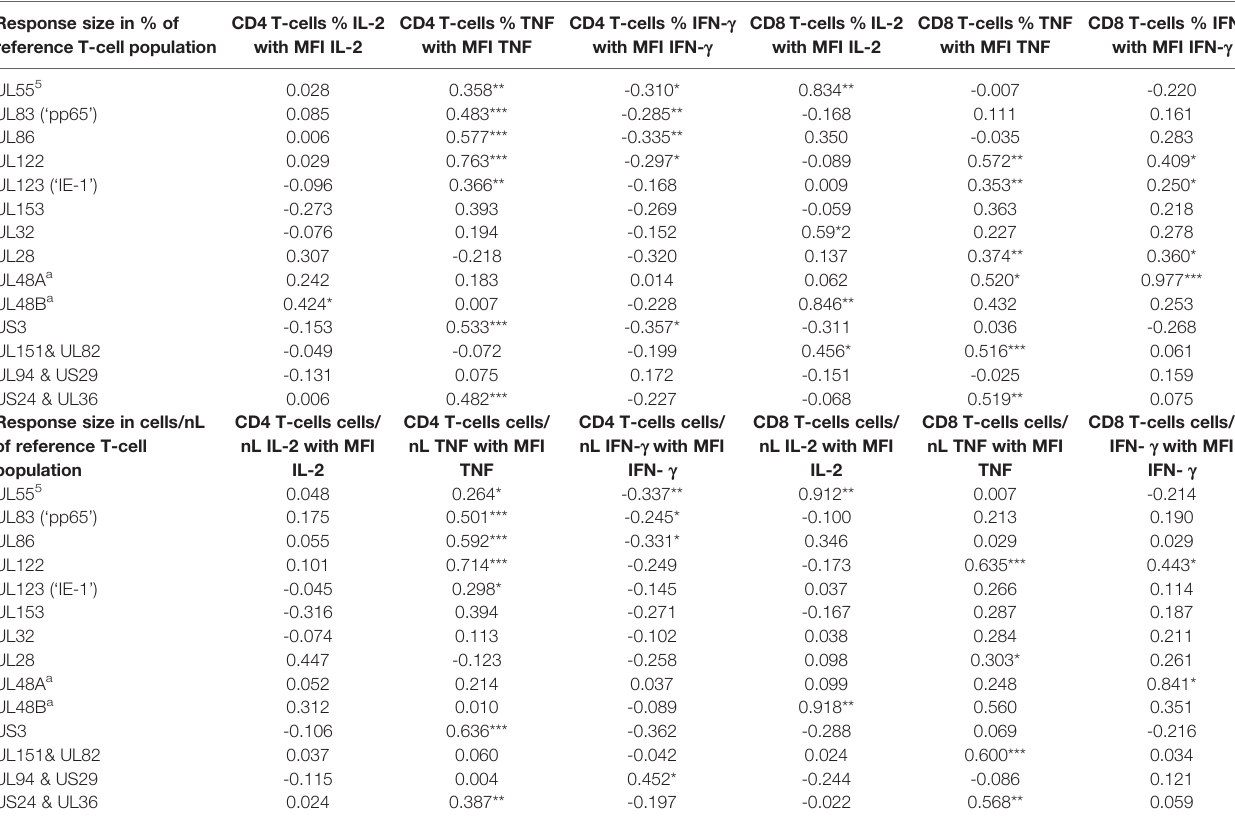
TABLE 5 | Association of T-cell response size with cytokine